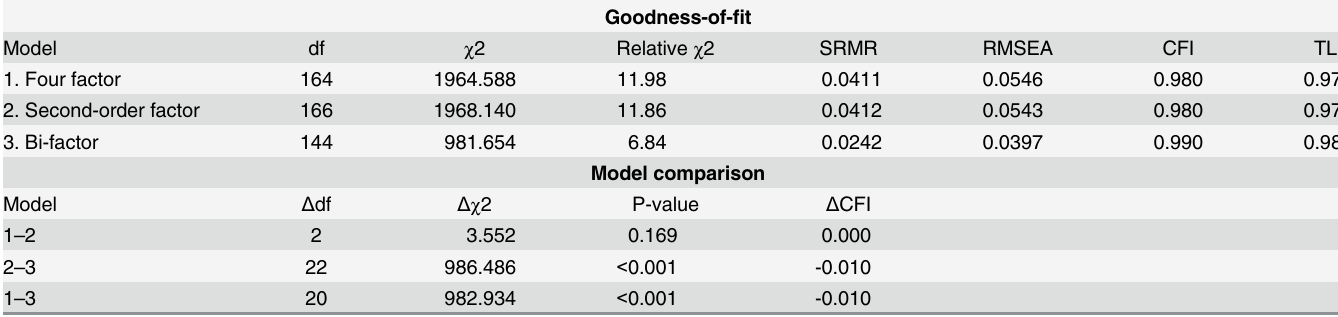
Table 3. Goodness-of-fit statistics of each model and model